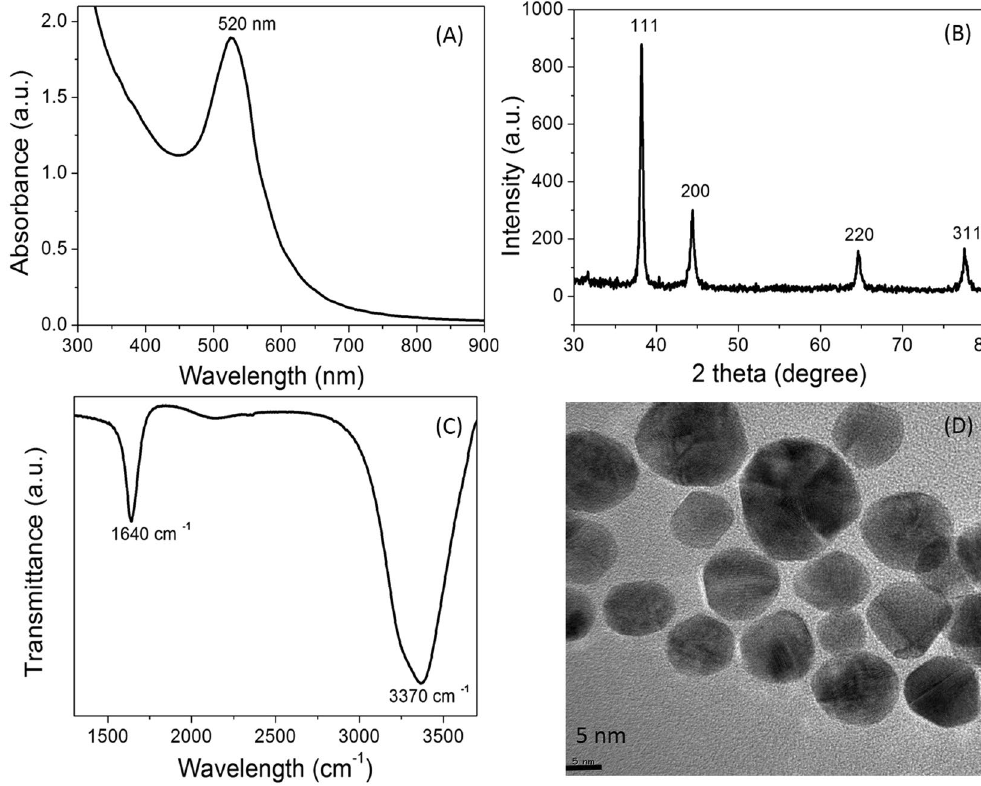
Figure 2. Characterization of the tryptophan capped AuNPs. ( A ) UV-Vis spectrum of the AuNPs, ( B ) XRD spectrum of the AuNPs, ( C ) FTIR spectrum of the AuNPs, ( D ), TEM imaging of the AuNPs.